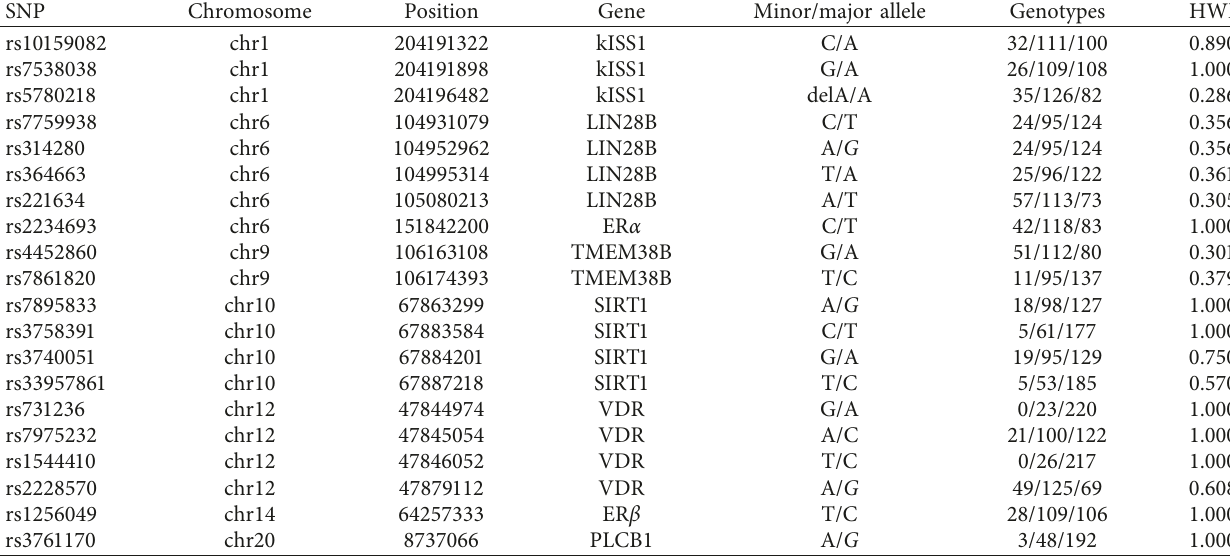
Table 2: Primary information of selected single nucleotide polymorphisms.